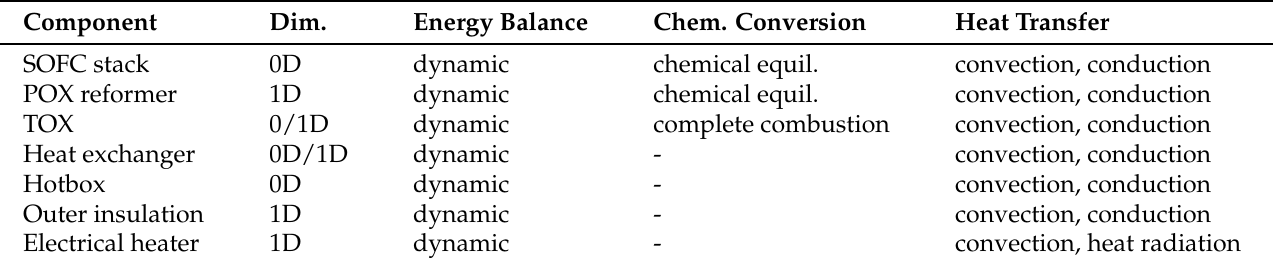
Table 2. Model assumption of the components for the dynamic system model.